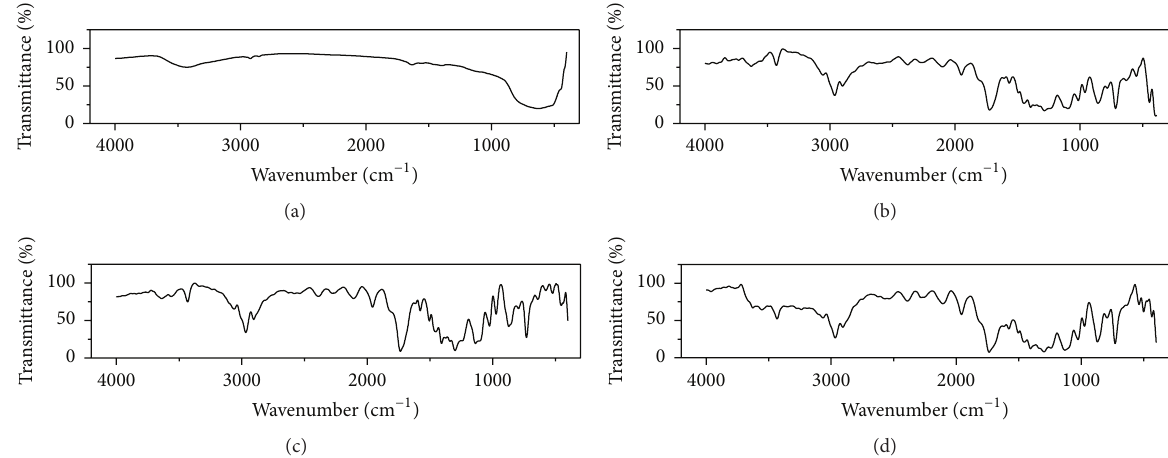
Figure 3: FT-IR spectra of (a) TiO 2 , (b) pristine PET, (c) TiO 2 coated PET, and (d) solar irradiated TiO 2 coated